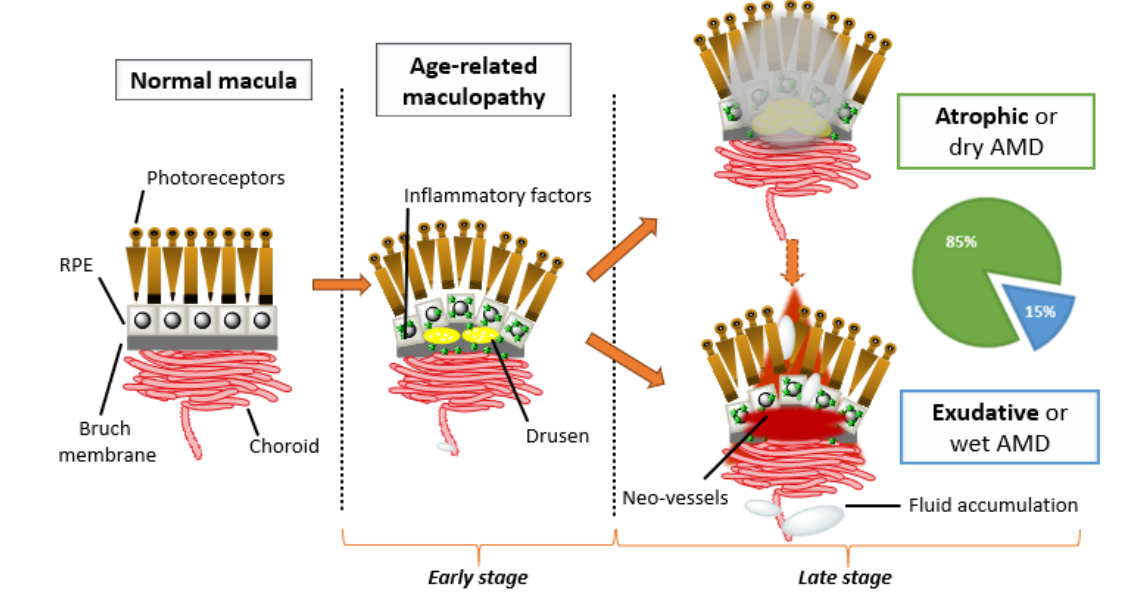
Figure 7. The different AMD stages starting from normal macula. Age-related maculopathy (ARM), which is characterized by the appearance of drusens and inflammatory factors, then worsens in atrophic AMD and/or in exudative AMD with neovascularization and vascular leakage. RPE: retinal pigment epithelium.